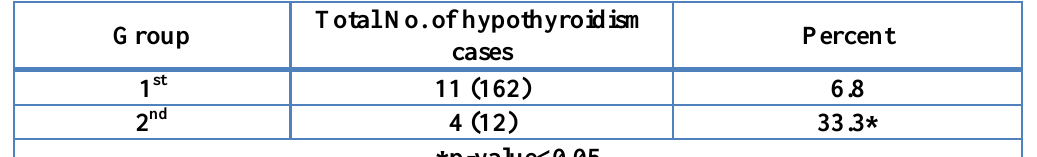
Table 4: Comparison of results in both